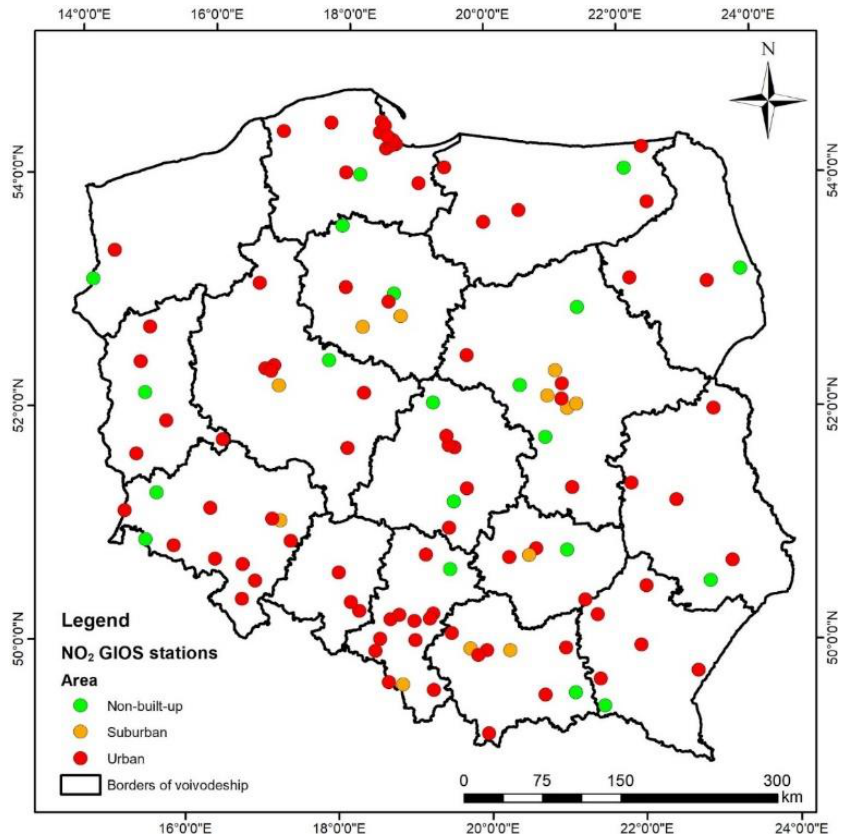
Figure 1. Location of the GIOS stations measuring atmospheric NO 2 mass concentrations. The green circles correspond to stations located over non-built-up areas (background stations), the orange circles correspond to stations located over suburban areas, and the red circles correspond to stations located over urban areas.